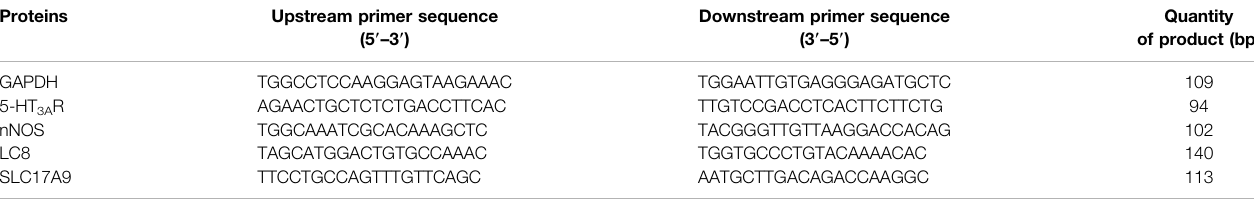
TABLE 1 | Primers used for qRT-PCR in this